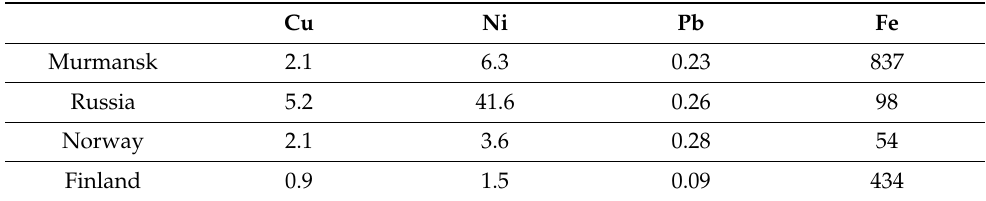
Table 3. The mean contents of microelements in the Murmansk lakes and the neighboring zones of Russia, Norway, and Finland, µ g/L [41].